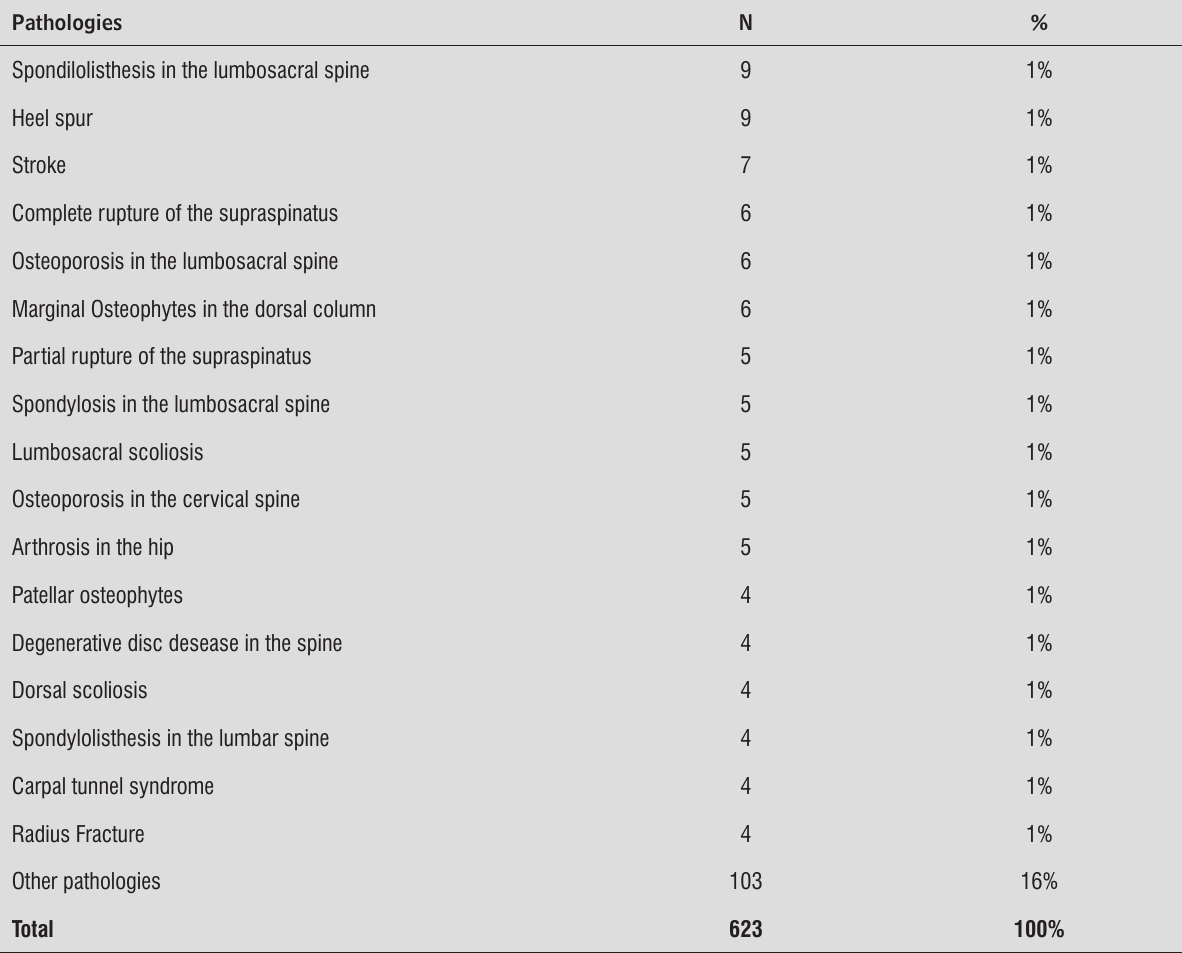
Table 1 - Main pathologies treated in the physiotherapy public sector in Boa Vista do Cadeado city – Rio Grande do Sul state Pathologies N Spondilolisthesis in the lumbosacral